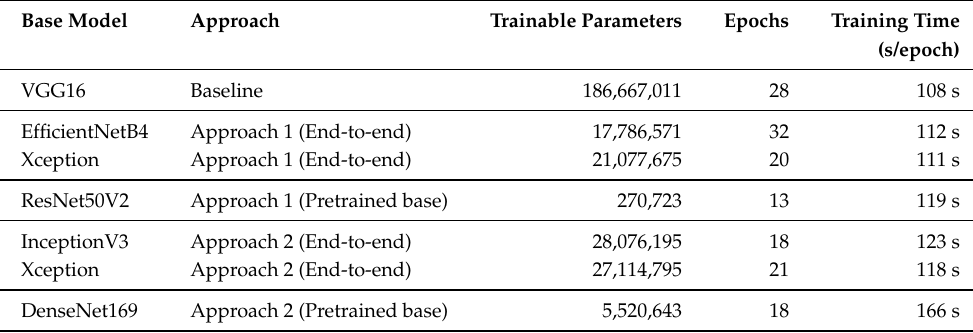
Table 5. Execution time and size of the best-performing